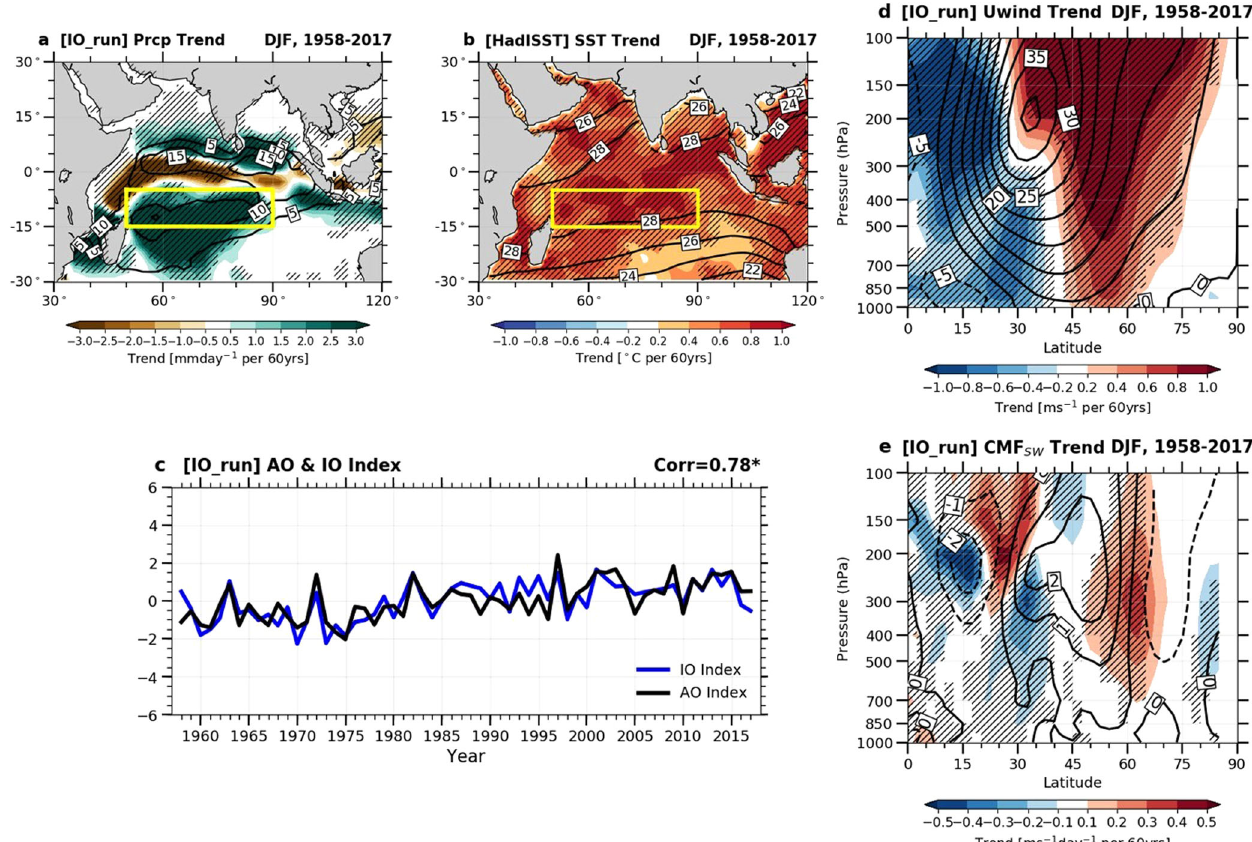
Fig. 5 Long-term trends of precipitation and zonal-mean zonal winds in the IO_run. a The linear trend of precipitation in DJF in IO_run (shading) with the climatological precipitation (contour, unit: mmday − 1 ) and b the linear trend of the observed SST in DJF in HadISST data (shading) with the climatological SST (contour, unit: °C). c Time-series of AO index and area-averaged precipitation anomalies in the western- to-central Indian Ocean (IO index, yellow box in Fig. 5a, b). Both indices are standardized and the correlation coef fi cient (Corr) between two indices is statistically signi fi cant at a 99% con fi dence level (*). d The linear trend of zonal-mean (0° – 360°E) zonal winds in DJF in IO_run (shading) with the climatological zonal-mean zonal winds (contour, unit: ms − 1 ) and e the linear trend of convergence of momentum fl ux by the stationary waves (CMF SW ) in DJF in the IO_run (shading) with the climatological CMF SW (contour, unit: ms − 1 day − 1 ). In all fi gures, the black hatched regions indicate statistically signi fi cant regions at a 95% con fi dence